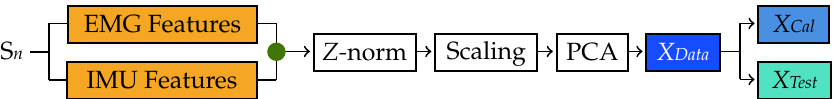
Figure 4. Training flow for the Adaptive LS-SVM classification method during each cross-validation iteration using both EMG and IMU data. A similar procedure was used for the EMG only dataset. Data from Subject S n in the cross-validation testing fold (orange) are split into X Cal and X Test , which are then used to calibrate and test the classification models in Figure 5. The green dots represent a feature-level fusion.